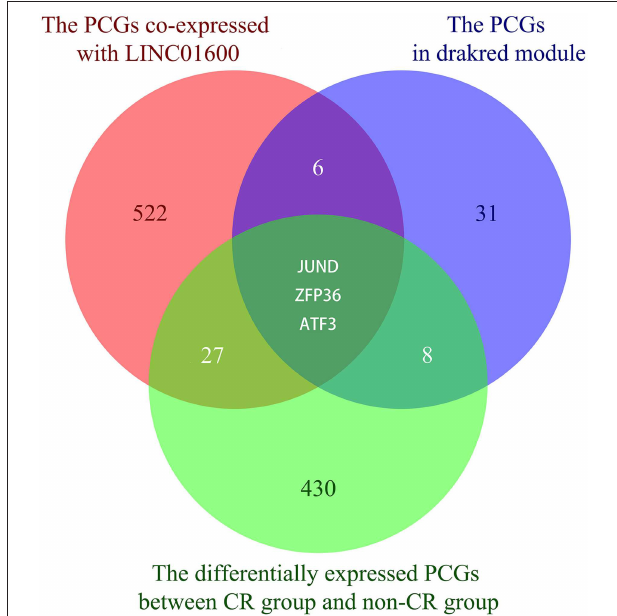
FIGURE 4 | The Venn diagram shows the intersection of the 558 PCGs co-expressed with LINC01600, the 48 PCGs in the drakred module obtained by WGCNA, and the 468 differentially expressed PCGs between CR group and non-CR group.